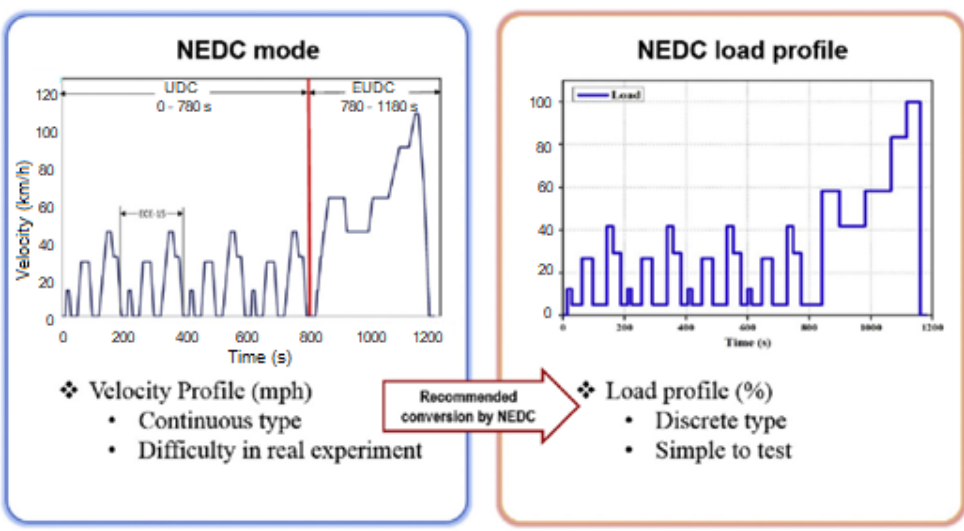
Figure 3. Schedule of Fuel Cell Dynamic Load Cycle (FC-DLC) profile of the New European Driving Cycle (NEDC) [121] (Reproduced with permission from Jeasu Han et al. [121], International Journal of Hydrogen Energy; published by Elsevier Ltd., 2020).